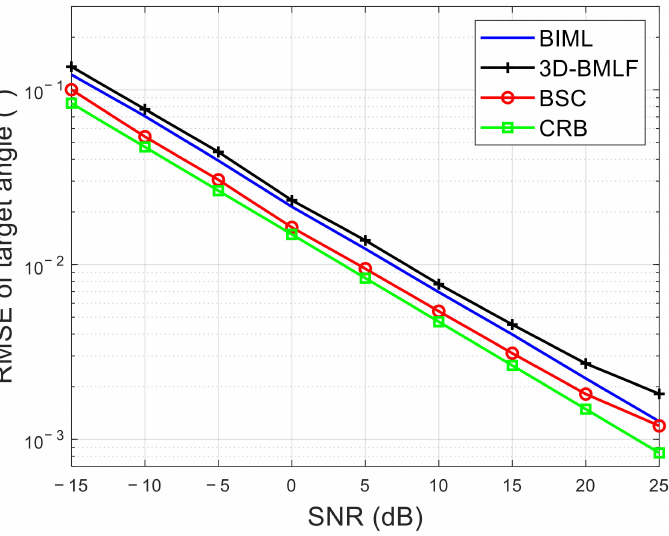
Figure 5. The RMSEs of the target angle for the three algorithms against the